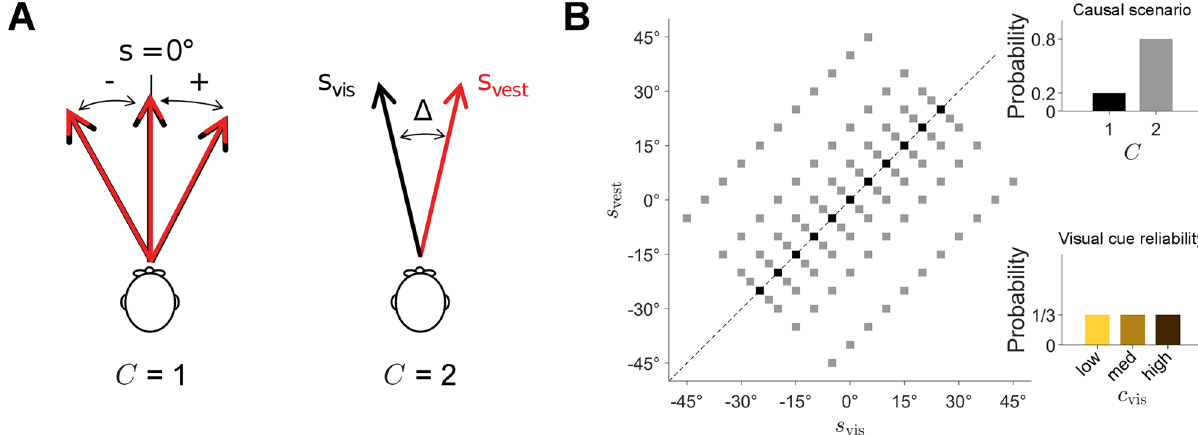
Fig 1. Experiment layout. A : Subjects were presented with visual ( s vis ) and vestibular ( s vis ) headings either in the same direction ( C = 1) or in different directions ( C = 2). In different sessions, subjects were asked to judge whether stimuli had the same cause (‘unity judgment’, explicit causal inference) or whether the vestibular heading was to the left or right of straight forward (‘inertial discrimination’, implicit causal inference). B : Distribution of stimuli used in the task. Mean stimulus direction was drawn from a discrete uniform distribution ( − 25˚, − 20˚, − 15˚, ... ,25˚). In 20% of the trials, s vis (cid:17) s vest (‘same’ trials, C = 1); in the other 80% (‘different’, C = 2), disparity was drawn from a discrete uniform distribution ( ± 5˚, ± 10˚, ± 20˚, ± 40˚), which led to a correlated pattern of heading directions s vis and s vest . Visual cue reliability c vis was also drawn randomly on each trial (high, medium, and